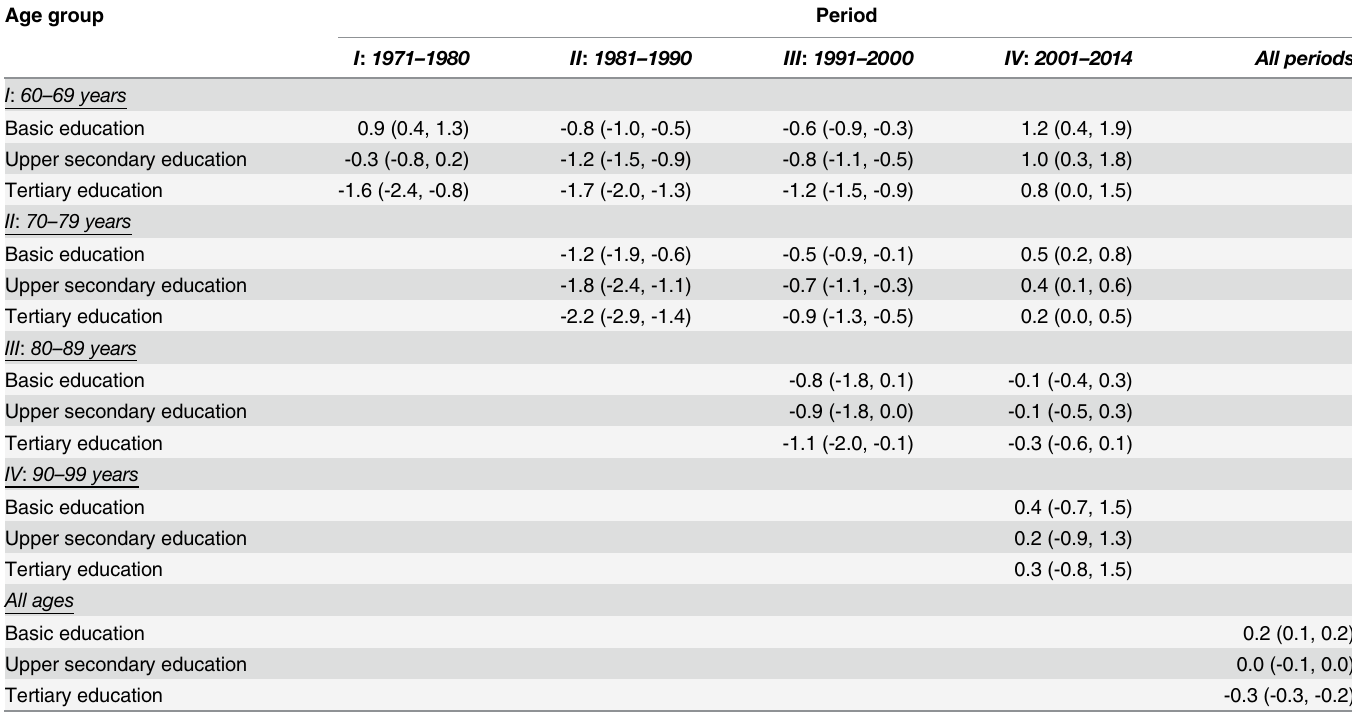
Table 5. Average annual change in hospital admissions, in per cent (95% CI), estimated from clog-log models by age group and period, women. Age